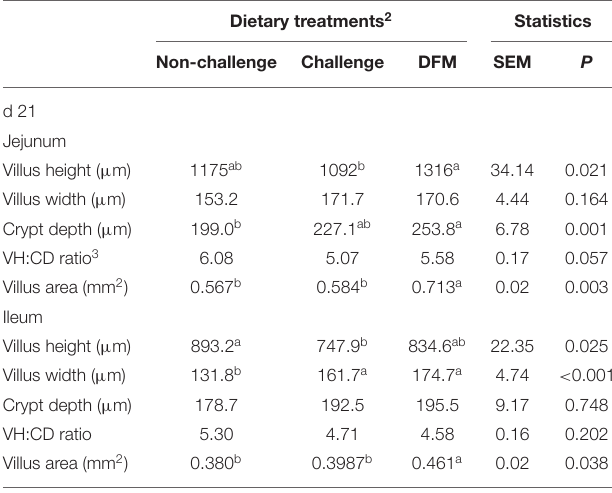
TABLE 2 | Effect of dietary DFM supplementation on broiler jejunum and ileum histomorphology 6 days after post challenge (d 21) 1 . Dietary treatments